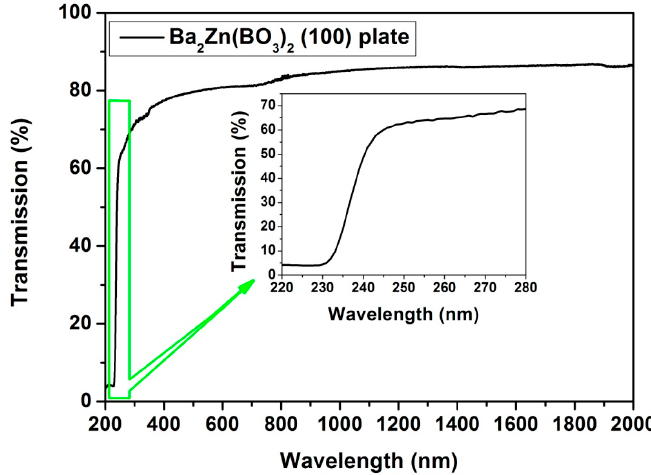
Figure 4. UV-vis-NIR transmission spectra of Ba 2 Zn(BO 3 ) 2 (100) plate. Insert is enlarged UV range.